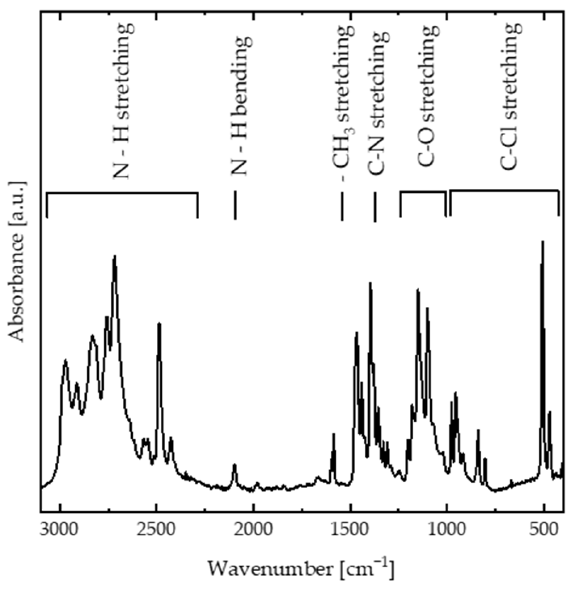
Figure 1. The FTIR spectrum of DIPAC.